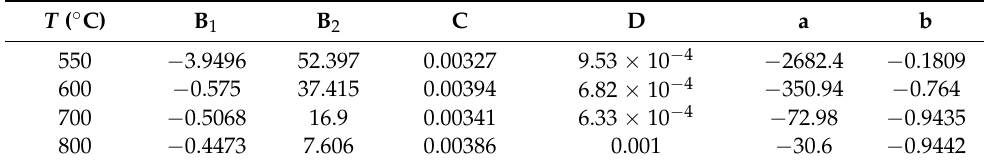
Table 6. Values of the parameters in Equations (13) and (14).